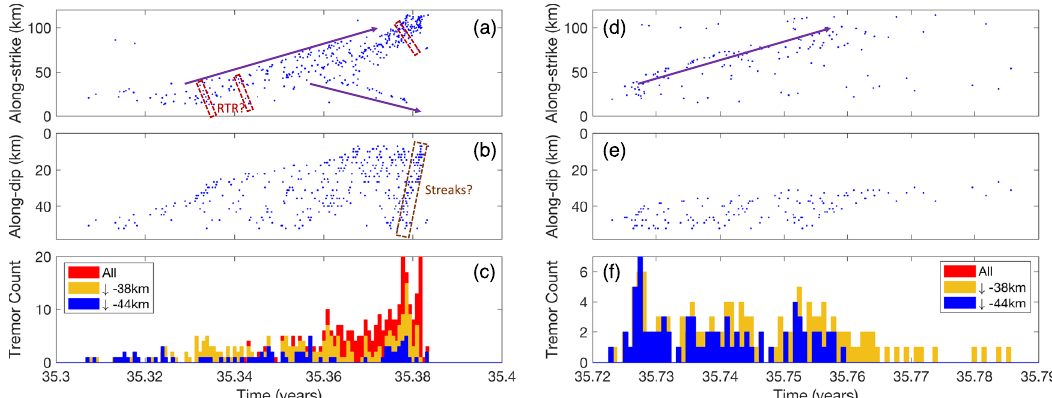
Fig. 6 Modeled episodic tremor and slow-slip (ETS) variability. Similar to Fig. 2 with additional plot of seismicity projected to along-dip direction ( b , e ). a – c Zoomed-in view of a major ETS event. Bottom panel shows tremor activities binned in 6-h window. The ETS nucleates at deep part and propagates bilaterally along-strike with rupture speed of approximately 4~5 km per day, with one branch of more tremor activities than the other, and the ETS progressively propagates up-dip. Examples of possible rapid tremor reversals (RTRs) are indicated with red dashed boxes. Note also the plausible along-dip fast “ tremor streaks ” (indicated with brown dashed box) toward the end of the ETS as suggested by 42,46 . d – f Zoomed-in view of a deep ETS, which stays mostly in the deep portion of the fault, with a general trend of up-dip